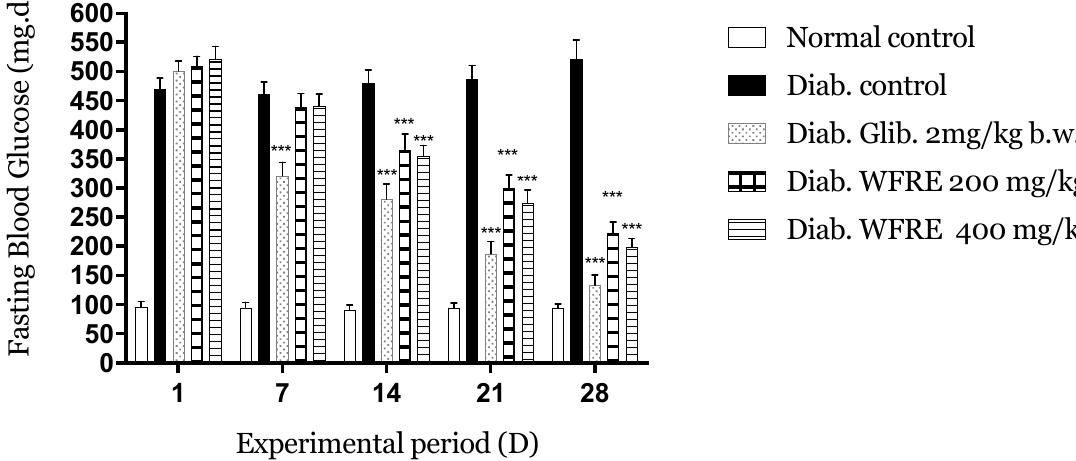
Figure 2. Fasting blood glucose changes occurred in alloxan-induced diabetic mice treated with plant extract for 28 days. ( * p < 0.05 means there was a significant difference between controls and treatments; *** p < 0.001 means there was a highly significant difference between controls and treatments)